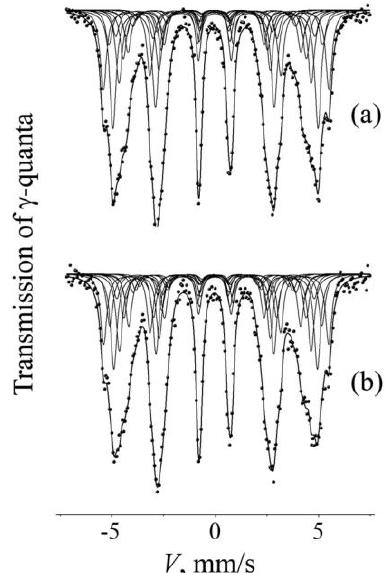
Figure 5. Spectra for the alloy Fe 86.8.2 Cr 13.2 . Treatment (state): ( a ) annealed at 1073 K (as-received) and aged at 773 K, 50 h; ( b ) aged and HPT (ε = 5.9, n = 3 rev.) at 80 K.